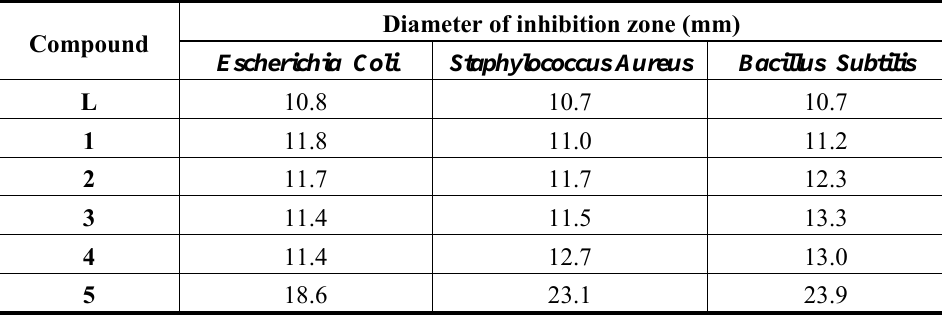
Table 3. Data of antibacterial activity of ligand and